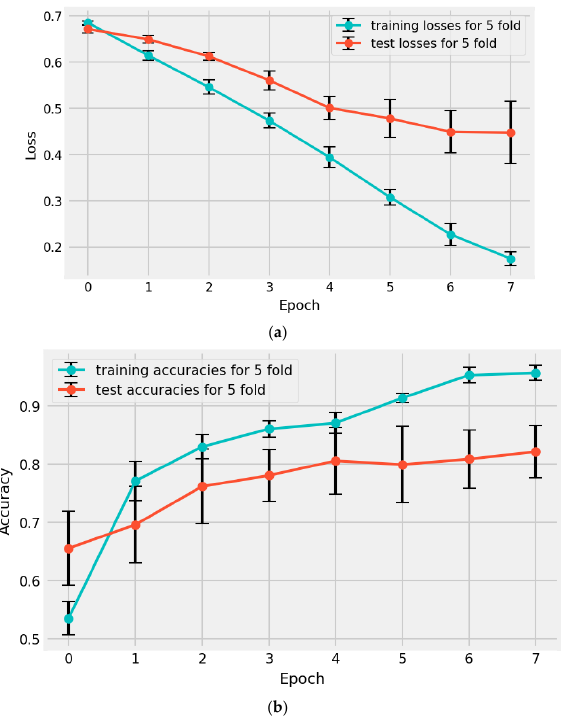
Figure 5. ( a ) Mean and standard deviation of all five folds’ losses per epoch; ( b ) mean and standard deviation of all five folds’ accuracies per